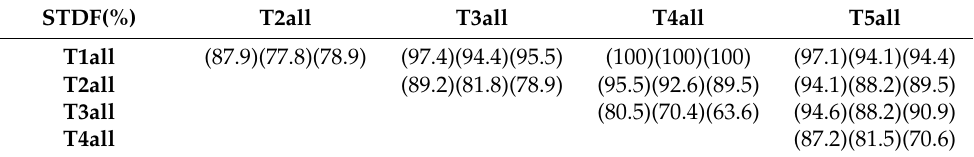
Table 6. Similarity between the enhanced Andersonian bulk stress